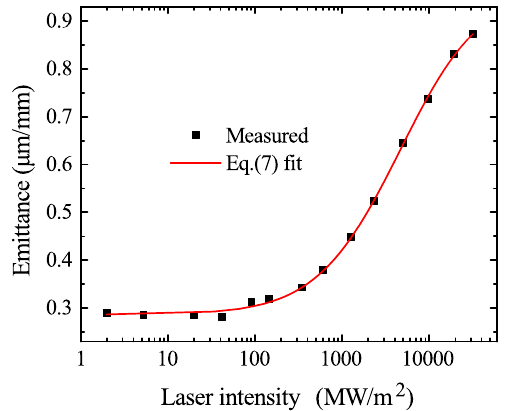
FIG. 6. Laser intensity dependence of measured emittance for 310 nm (4.00 eV). The average electron numbers per pulse were about 0.81 for the maximal laser intensity. Fitted with Eq. (7), the emittance is 0 . 29 μ m = mm for single-photon photoemission and 0 . 96 μ m = mm for two-photon